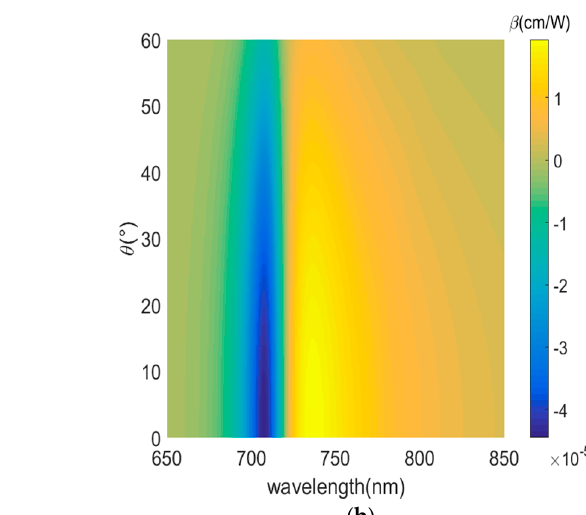
12 of 16 Table 1. Comparisons of the third-order nonlinear optical coefficients of different references. References